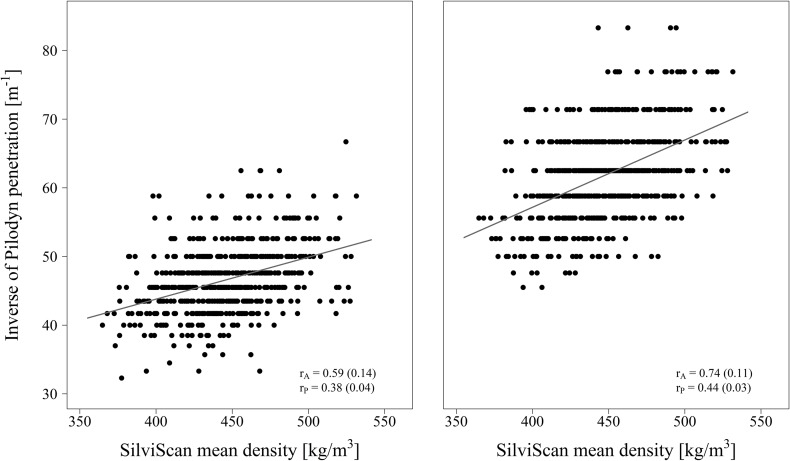
Relationship between SilviScan area-weighted mean density (DEN) and inverse value of Pilodyn penetration depth with bark (left) and without bark (right).